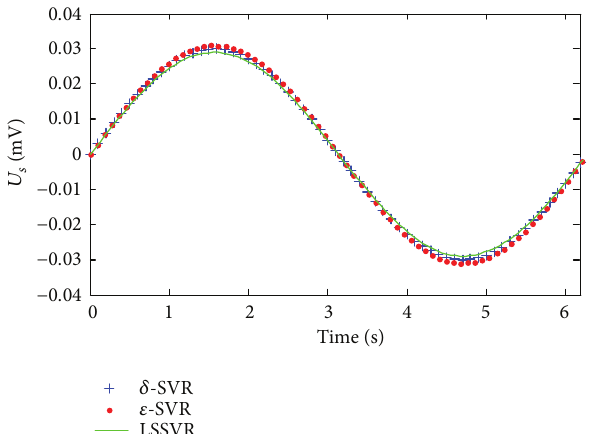
Figure 5: Local regression curve of input sensitivity ( 𝑈 𝑆 ) with the three